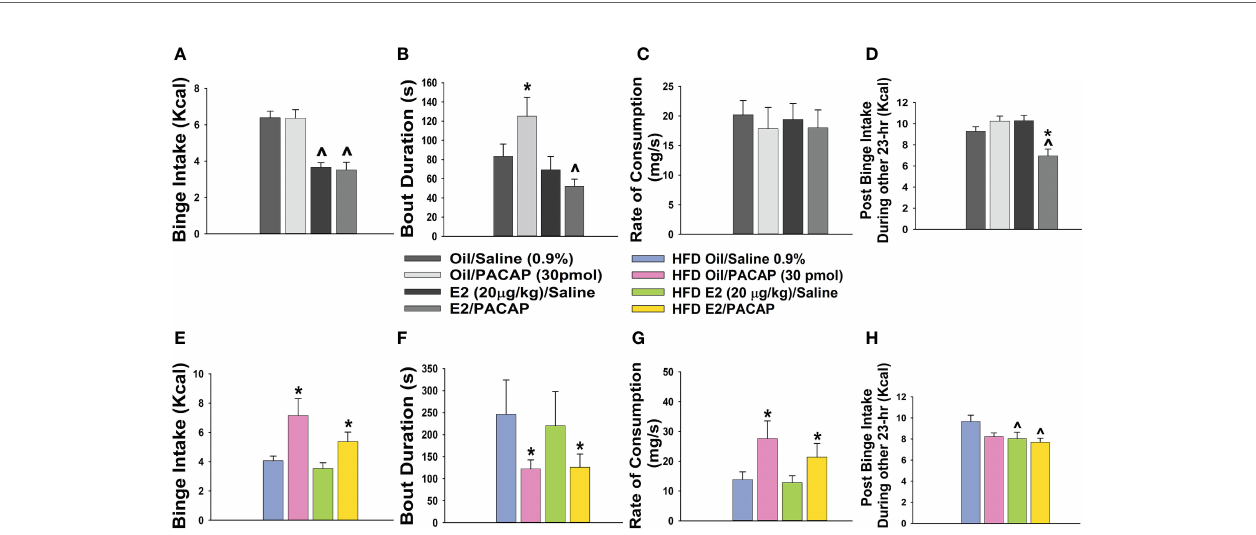
FIGURE 4 | Dichotomous effects of intra-VTA PACAP on binge feeding in OVX, lean vs obese, sesame oil- vs EB-treated female mice. In lean chow-fed mice, EB (20 m g/kg; s.c.) but not PACAP (30 pmol) decreases binge intake (A) , and signi fi cantly reduces bout duration in PACAP-treated animals (B) . Neither E2 nor PACAP have any effect on rate of consumption (C) . EB and PACAP work synergistically to decrease chow intake during the remaining 23 hours (D) . In obese HFD-fed animals given a one- week respite prior to implementation of the binge paradigm, PACAP increases binge intake in both oil- and EB-treated females (E) , which is associated with decreased bout duration (F) and increased rate of consumption (G) . EB reduces homeostatic feeding during the remaining 23 hours (H) . Bars represent means and lines 1 SEM. ^, p < 0.05; with respect to sesame oil; *, p < 0.05; with respect to saline; repeated measures, multi-factorial ANOVA/LSD (A – H) ; n = 6 for all treatment